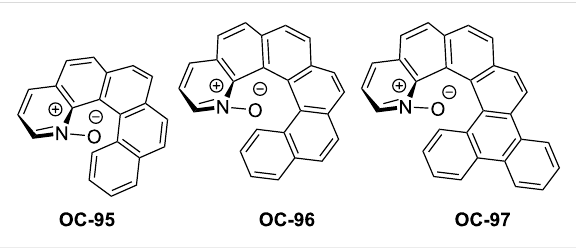
Figure 18: A novel family of helical chiral pyridine N -oxides OC-95 to OC - 97 .